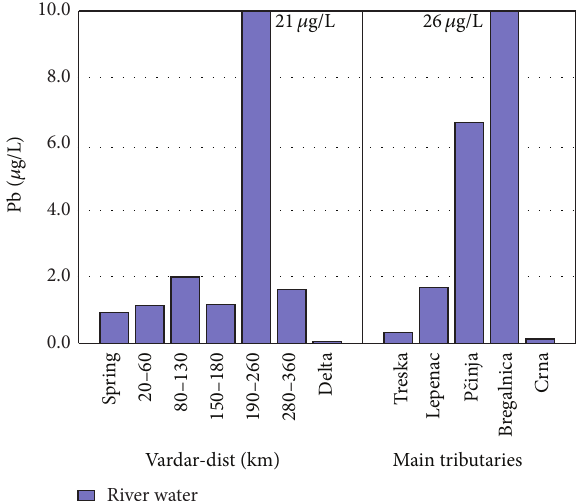
Figure 10: Concentration of Pb found in river Vardar and main tributaries.